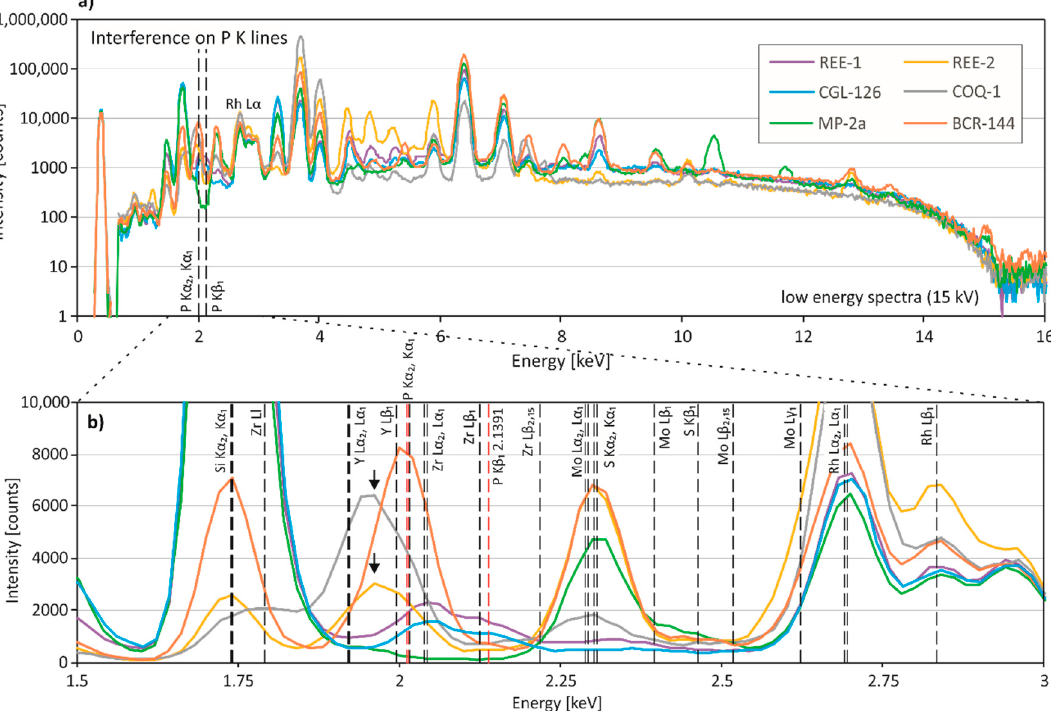
Figure 3. Spectral interferences on phosphorus. ( a ) Low-energy region (0–15 keV) and ( b ) close up of the representative X-ray fluorescence spectra for pXRF measurements of REE-1, REE-2, CGL126, COQ-1, MP-2a, and BCR-144. Phosphorus K α 1 - and K α 2 -lines (2.0137 and 2.0127 keV) and the P K β - line (2.1391 keV) are shown in red. Arrows indicate the Si escape peak for the Ca K α 1 - and/or K α 2 - lines in COQ-1 and REE-2. Excitation energy of the measurements was 15 kV.